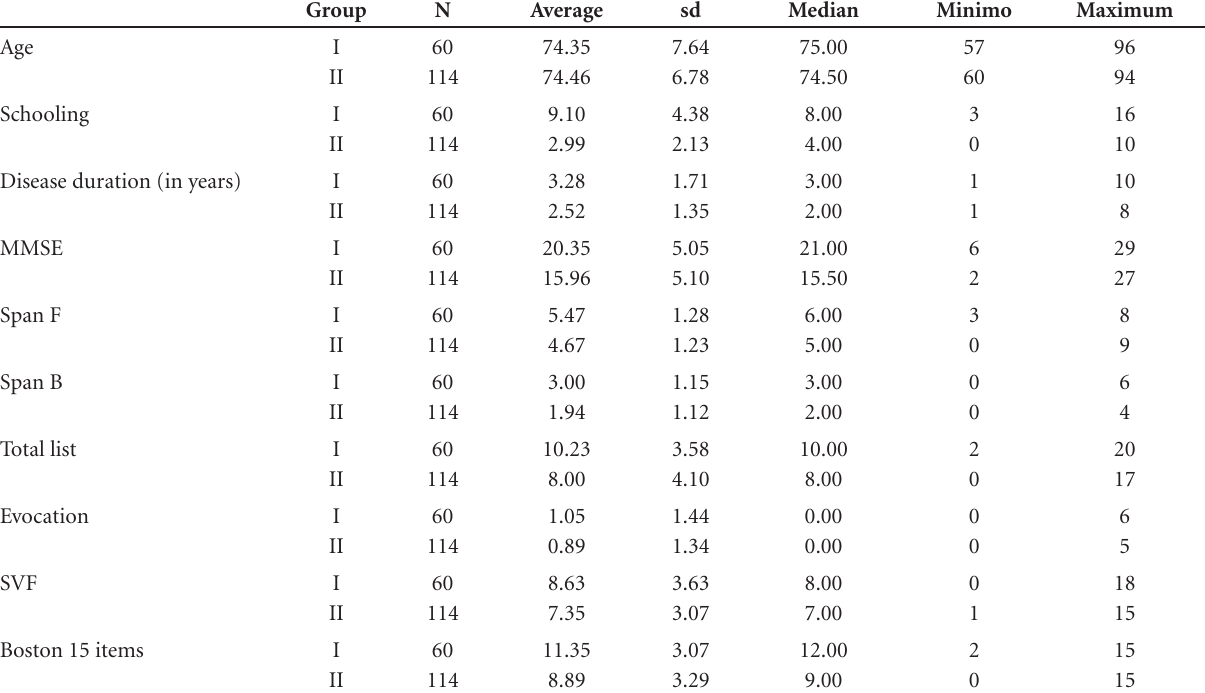
Table 2. Age, education, disease duration and neuropsychological performance. Group N